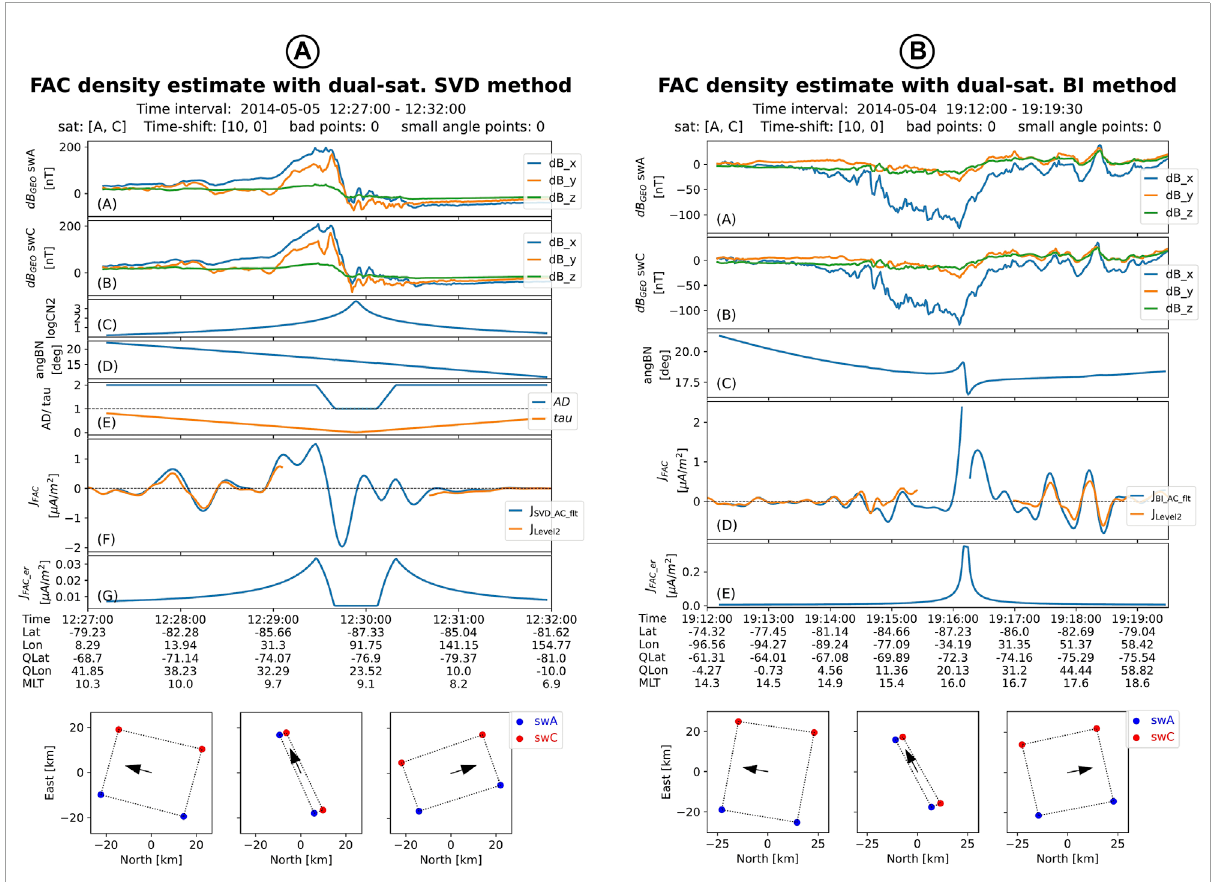
FIGURE 3 (A) : Standard plot generated by the j2satSVD algorithm. The figure is similar to Figure 2C , with an additional panel (the new panel E) that presents the evolution of eigenvalue ratio τ (orange line) and the array degeneracy AD (blue line). (B) : Standard plot generated by the j2satBI algorithm. The same quantities as in Figure 2C are plotted, with the exception of the condition number, which is not computed by the